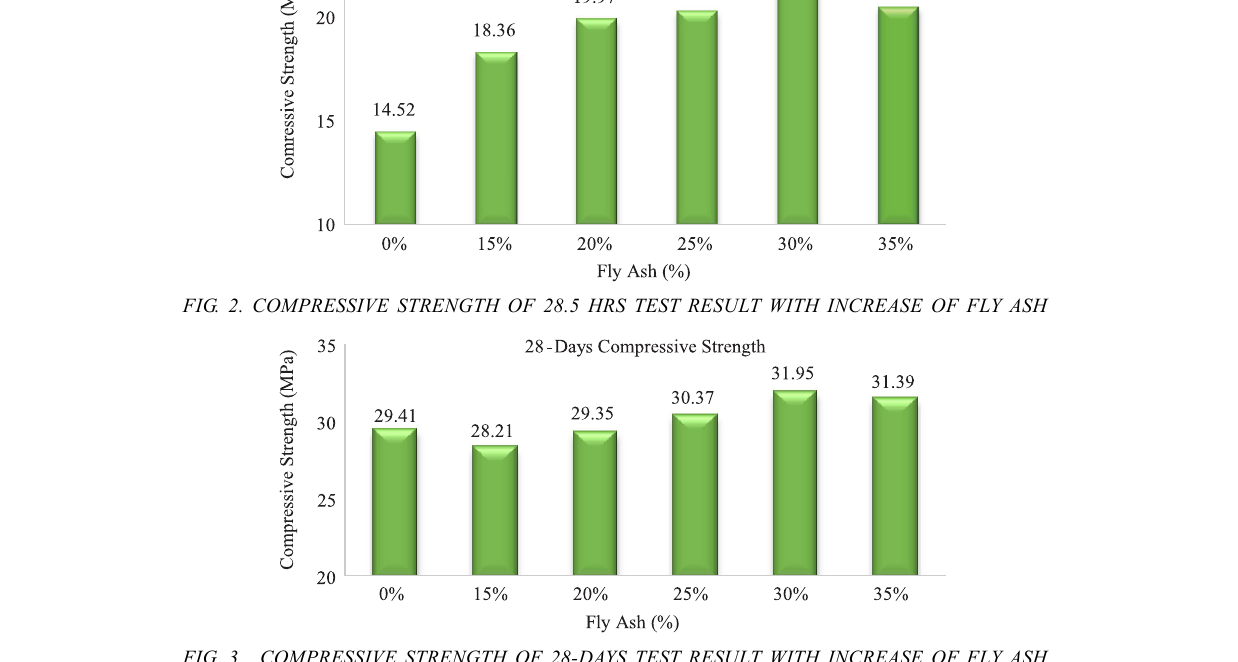
FIG. 3. COMPRESSIVE STRENGTH OF 28-DAYS TEST RESULT WITH INCREASE OF FLY